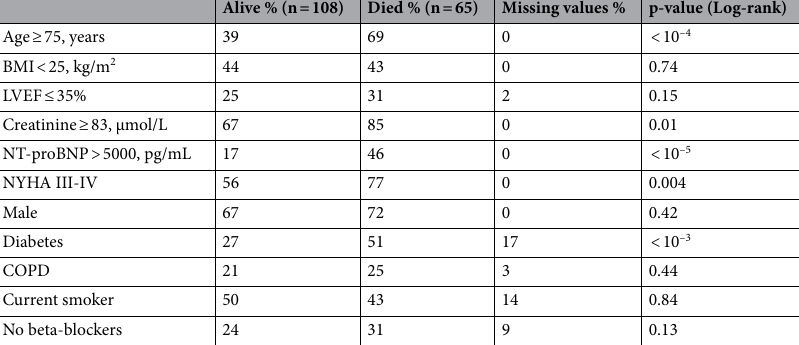
Table 2. Baseline variables considered for inclusion in the model. BMI body mass index; COPD chronic obstructive pulmonary disease; LVEF left ventricular ejection fraction; Nt-proBNP Nt-pro brain natriuretic peptide; NYHA New York Heart